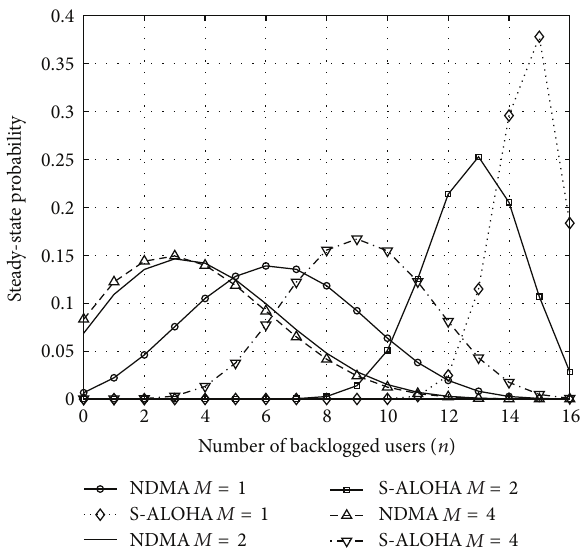
F 4: Steady-state probability distribution users with